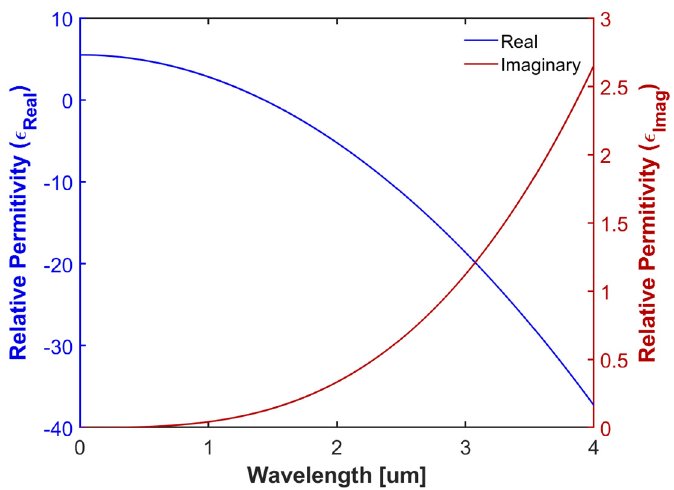
Figure 2. The relative permittivity of CdO.